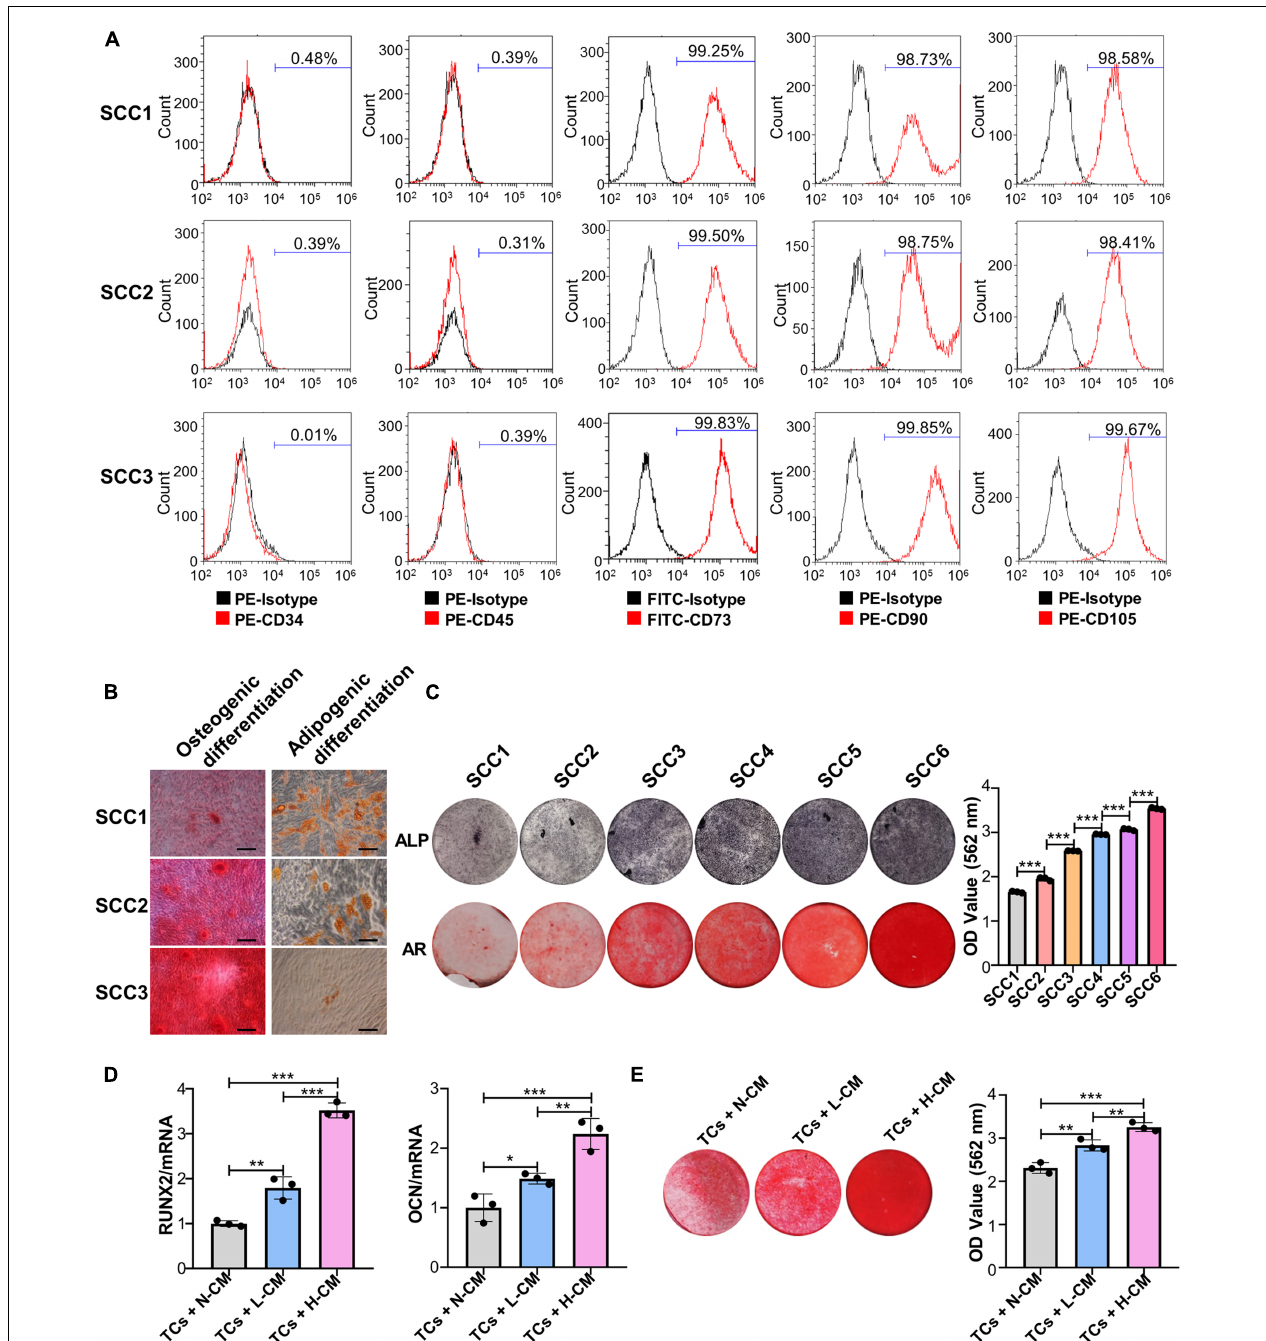
FIGURE 1 | Single-cell colonies with high osteogenic ability had a greater mineralization promotion ability than L-SCCs. (A) The presence of cell surface markers of three SCCs was detected by flow cytometry. (B) The osteogenic and adipogenic differentiation potential of the three SCCs were assessed by Alizarin red and Oil Red O staining. (C) The osteogenic differentiation abilities of SCCs were tested by alkaline phosphatase (ALP) and Alizarin red staining. Alizarin red staining was quantified after the addition of 10% cetylpyridinium chloride. (D) Conditioned medium collected from H-SCCs or L-SCCs was mixed with equal volumes of twofold concentrated osteogenic induction medium, and was used to stimulate the TCs toward osteogenic differentiation for 7 days, following which, the levels of the osteogenic differentiation-related genes in the TCs were tested by RT-qPCR ( n = 3). (E) Conditioned medium collected from H-SCCs or L-SCCs was mixed with equal volumes of twofold concentrated osteogenic induction medium, and was used to stimulate the TCs toward osteogenic differentiation for 28 days, following which, the TCs were subjected to Alizarin red staining ( n = 3). CM, conditioned medium; TCs, target cells; AR, Alizarin red; N-CM, normal culture medium; L-CM, conditioned medium from L-SCCs; H-CM, conditioned medium from H-SCCs. Scale bar, 50 µ m. * P < 0.05; ** P < 0.01; *** P < 0.001.